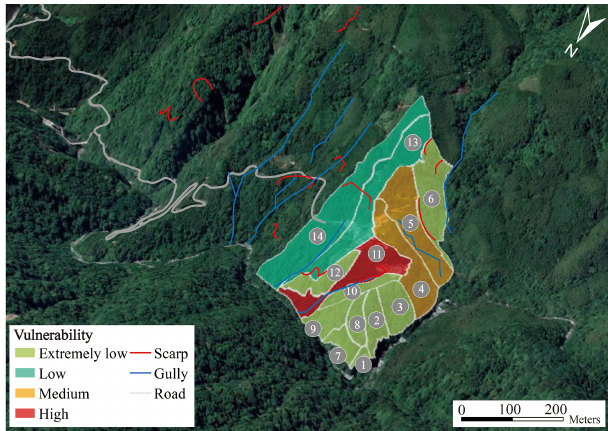
Figure 11. Vulnerability level mapping of landslide referring to units around the Neikuihui tribe (background: modified from © Google Earth 2021; aerial: ESRI ArcGIS